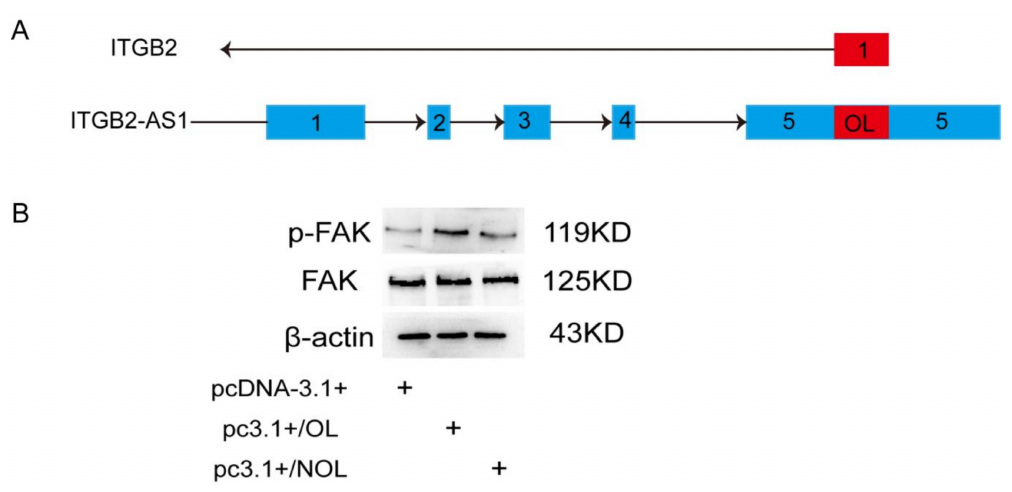
Figure 6. The OL fragment plays a critical role in the promotion effect of ITGB2-AS1 on MCF-7 cell. ( A ) The illustration of OL and NOL plasmid. Blue square: exon; arrow: transcription direction. ( B ) The FAK signaling was detected by western